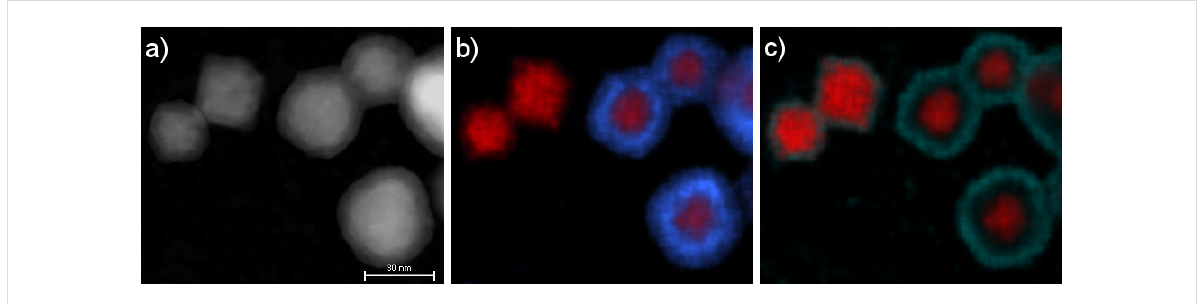
Figure 8: Quantitative EDX mapping revealing the underlying CS-structure: a) HAADF-STEM micrograph, b) Cu (blue) and Ni (red) distribution, c) O (green) and Ni (red) distribution. The length of the scale bar is 30 nm.